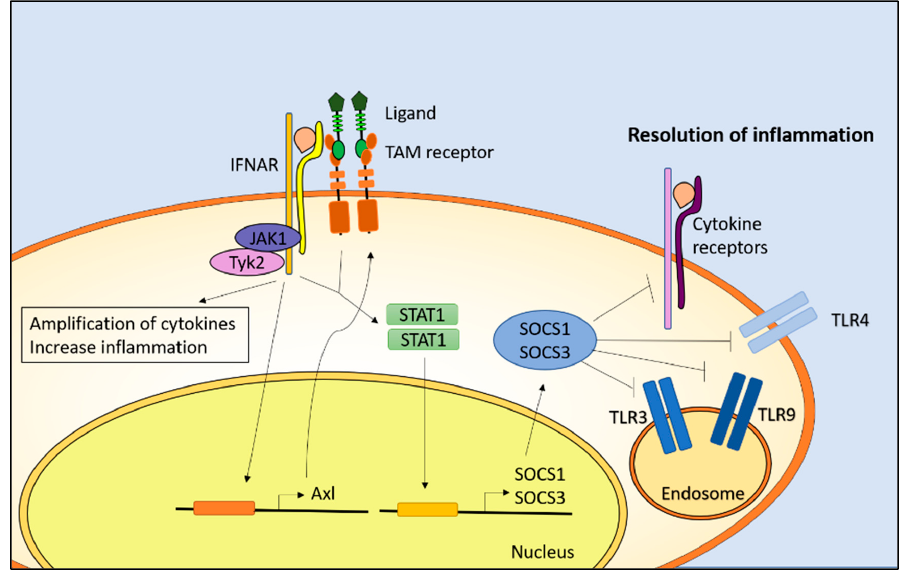
Figure 2. Activation of TAM receptors in dendritic cells down regulate inflammation. Activation